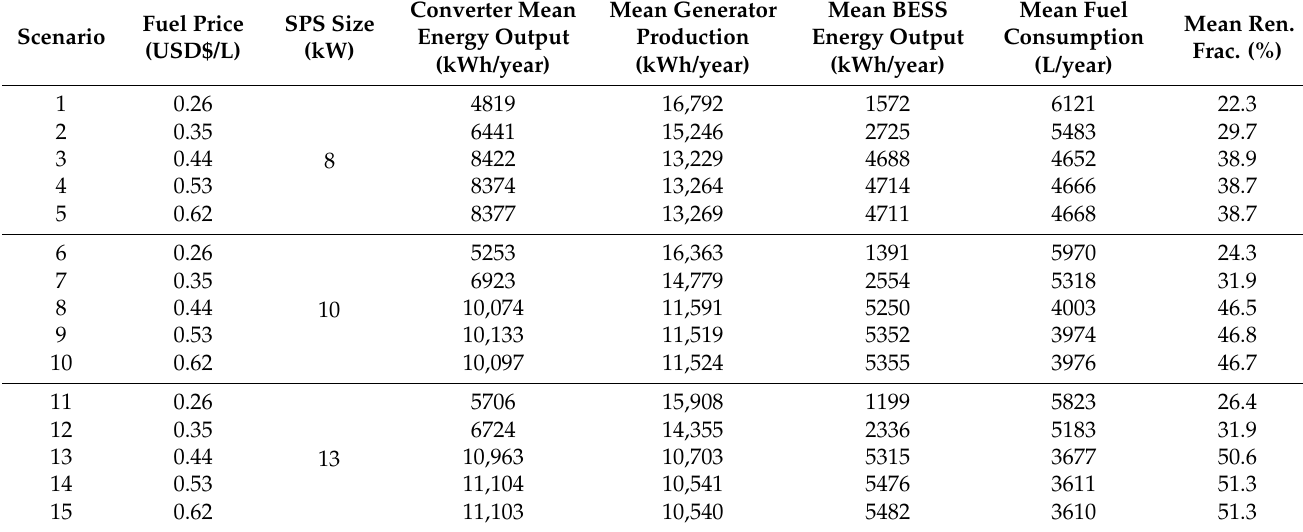
Table 5. Electricity production from DG, power converter, and battery energy storage system (BESS) according to each SPS size with its fuel prices over the 15-year project